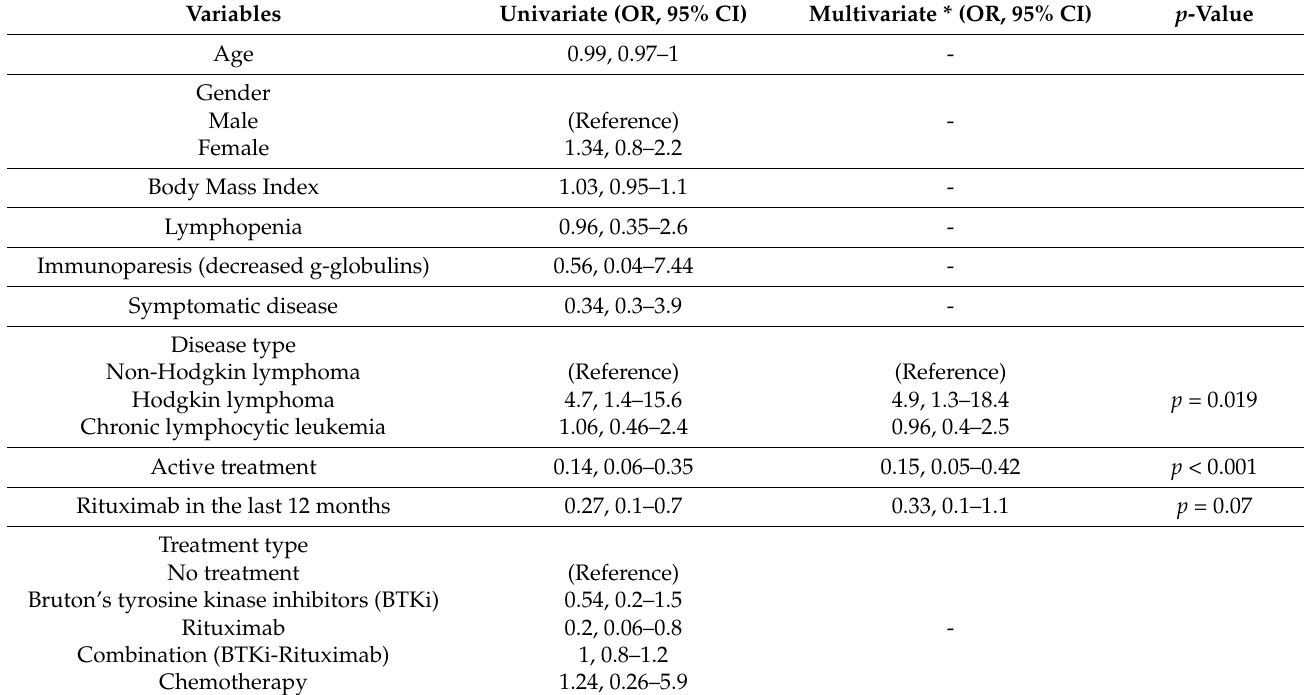
Table 2. Predictive factors for NAb production in patients as assessed in multivariate and univariate